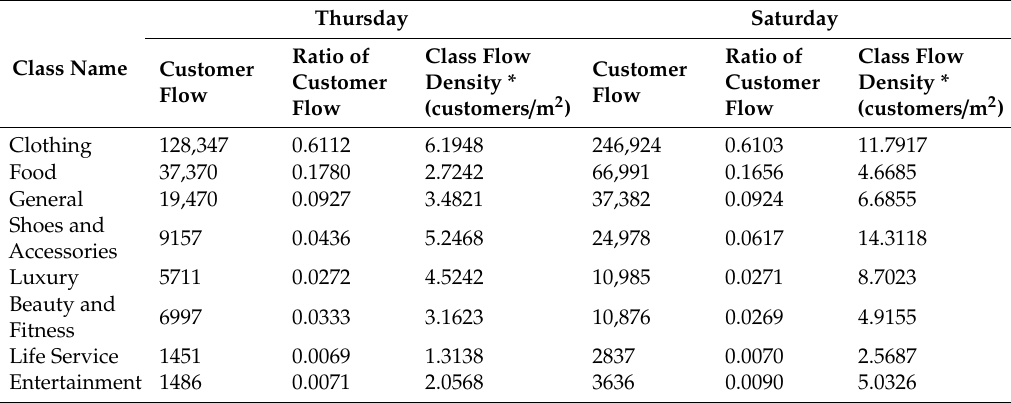
Figure 7. Store inflow histograms of ( a ) DYC and ( b ) LH. Table 2. Statistics of customer flows for store classes in DYC.